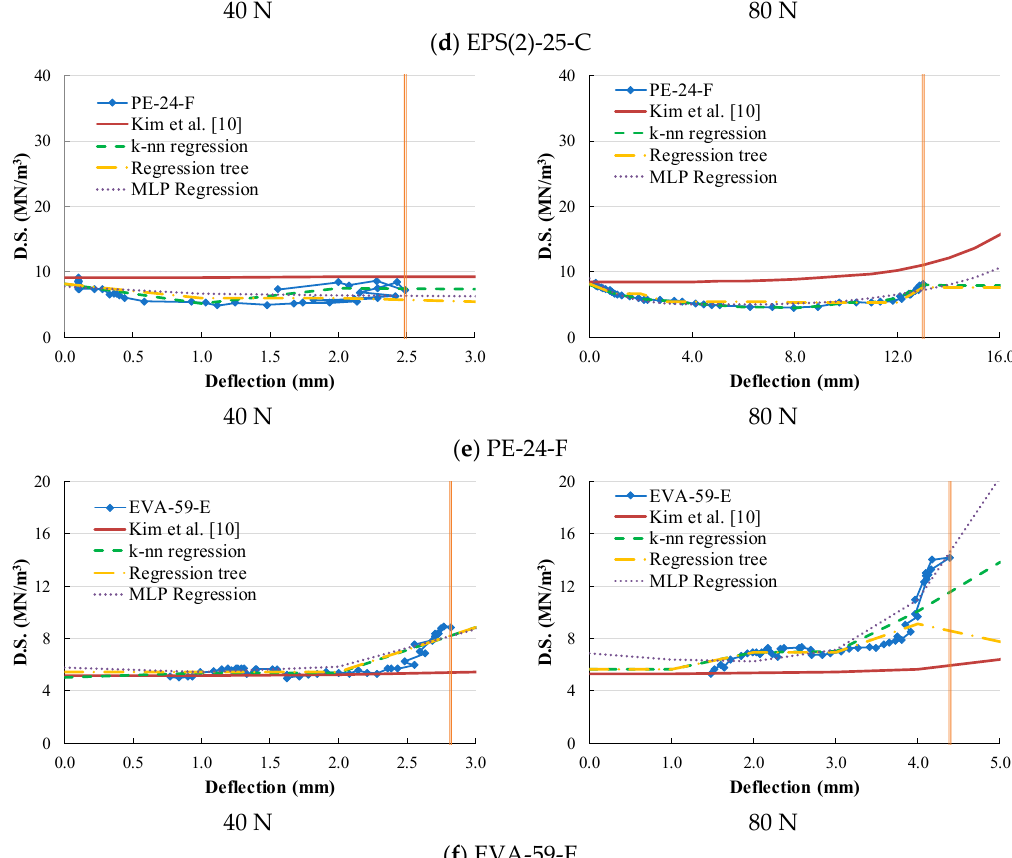
Figure A1. Dynamic stiffness comparisons between the test results and the equation for 40 N and 80 N.